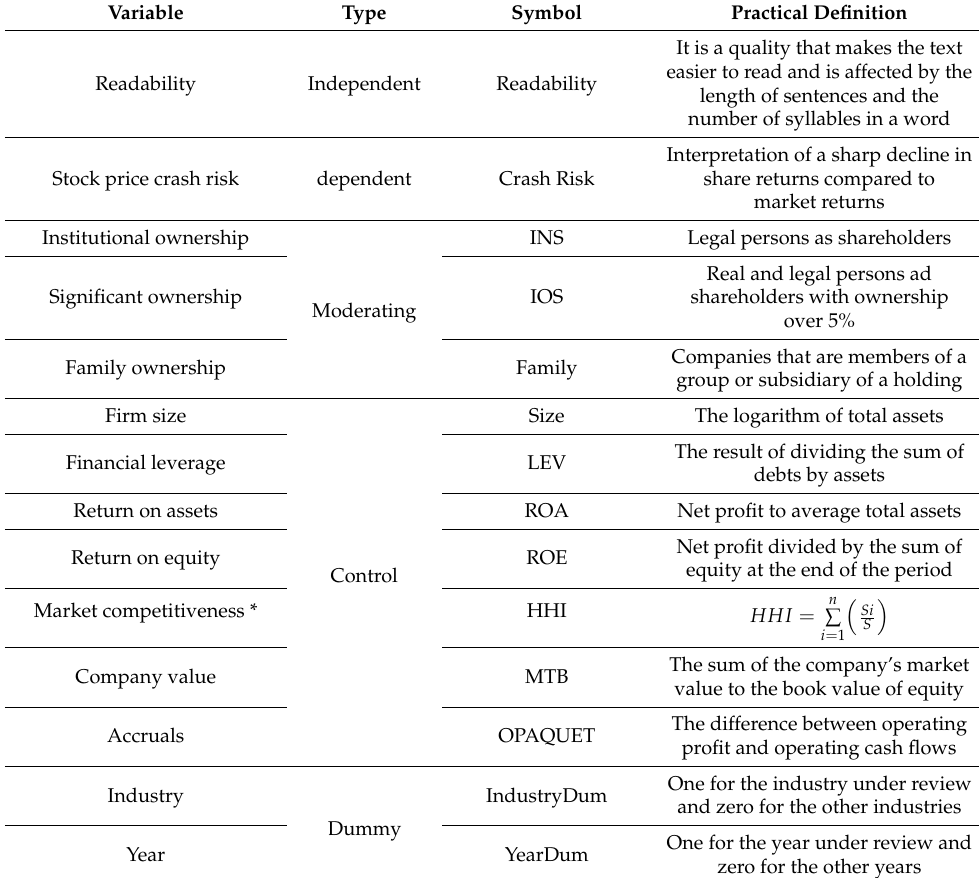
Table 1. Research